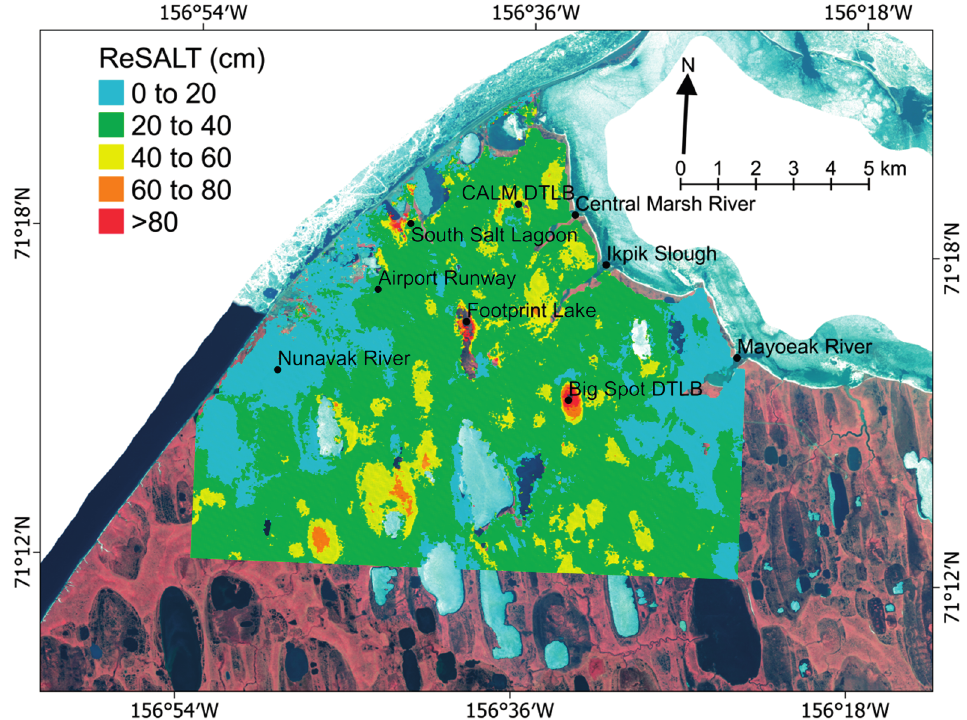
Figure 10. The ReSALT retrieval algorithm underestimated ALT around the Nunavak and Mayoeak Rivers due to a combination of unsaturated soils and InSAR data